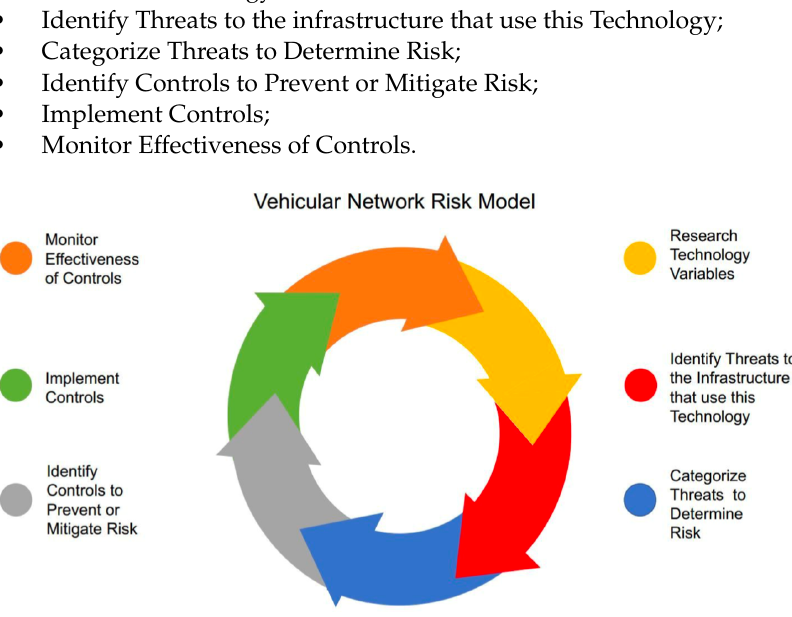
Figure 1. Vehicular Network Risk